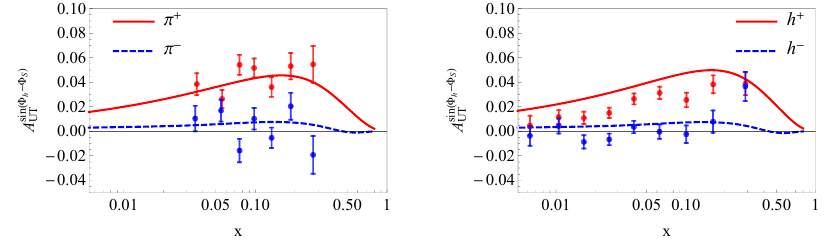
Figure 6. Sivers asymmetry A sin( (cid:30) h (cid:0) (cid:30) S ) for a proton target as function of x based on the (cid:12)t [136] UT in comparison to (left panel) HERMES [137] and (right panel) COMPASS [138]